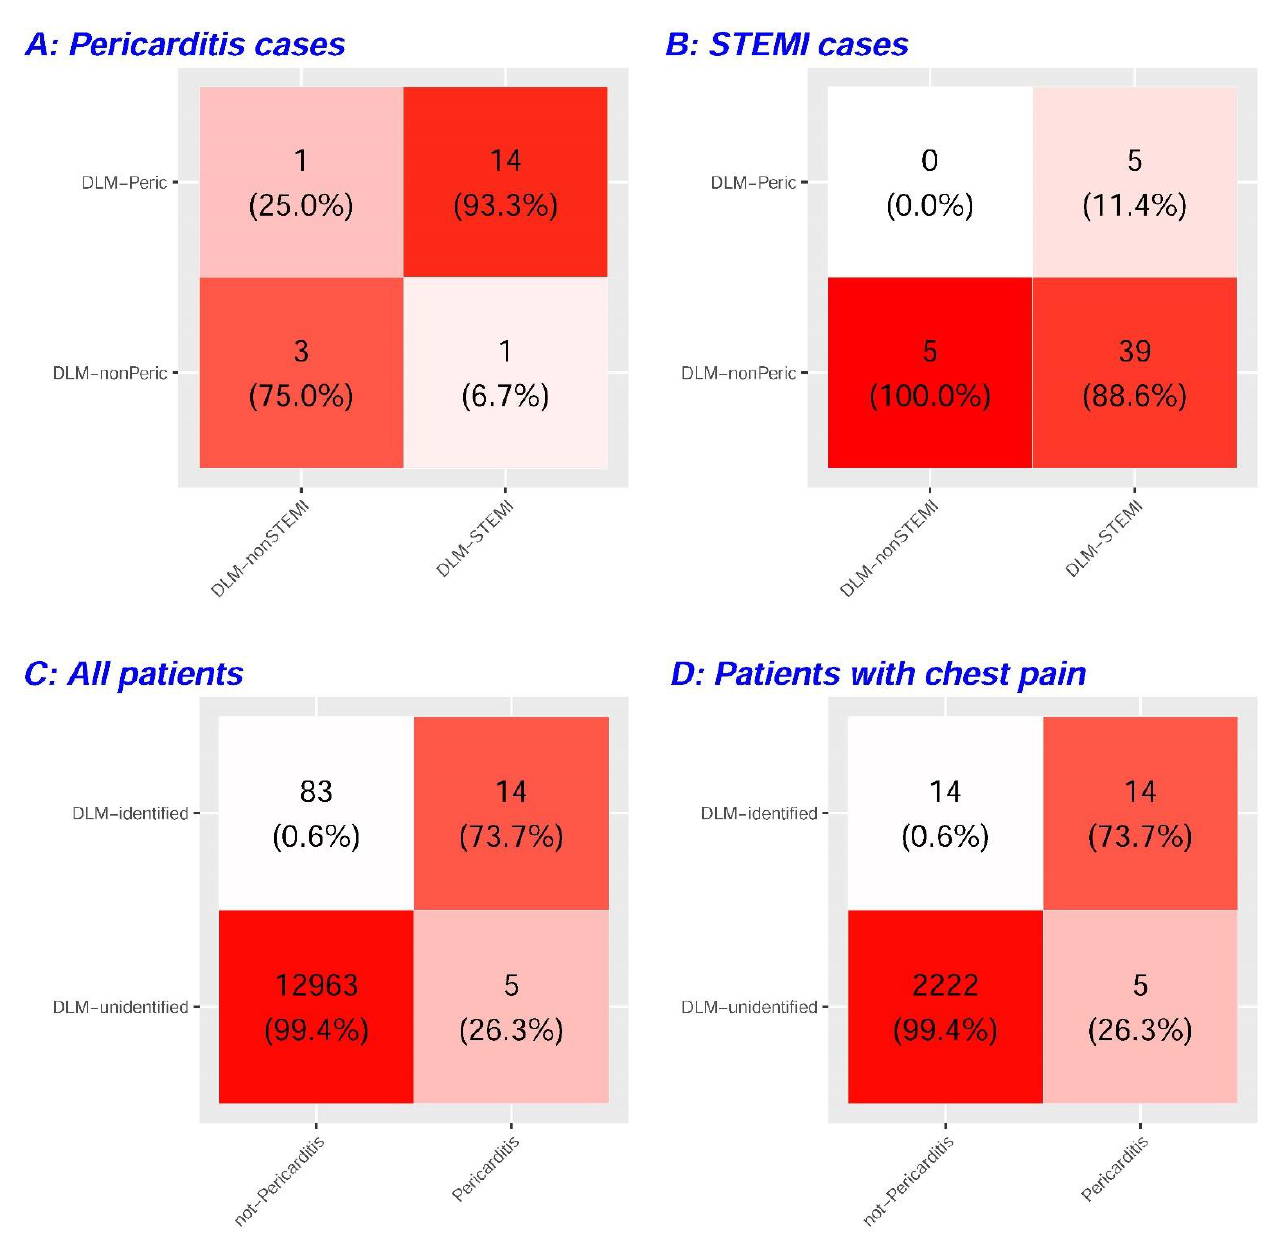
Figure 2. Integration of our pericarditis deep learning model (DLM) and previous STEMI DLM in the validation set. ( A ) The cross-table of predictions of two DLMs in pericarditis cases. ( B ) The cross-table of predictions of two DLMs in STEMI cases. ( C ) DLM identification was defined as the intersection of DLM-pericarditis and DLM-STEMI, which was defined as a new strategy to identify potential pericarditis cases. ( D ) The same strategy was applied to patients with chest